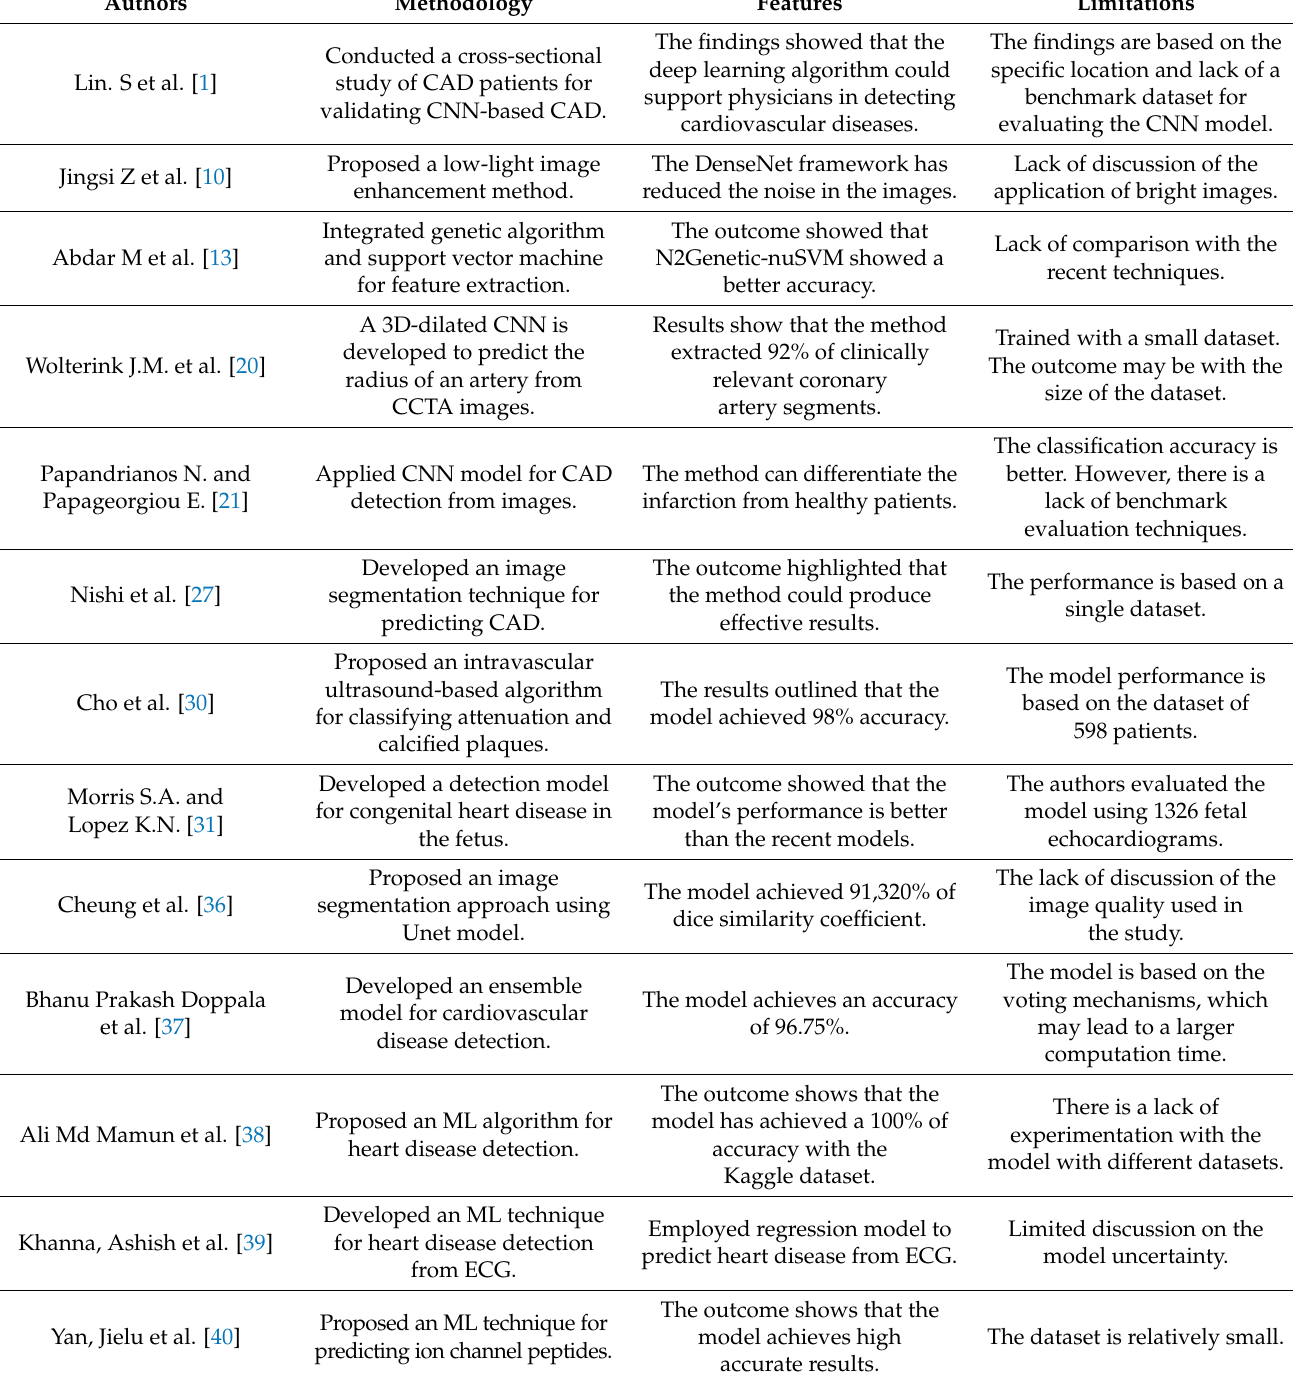
Table 1. Features of the existing